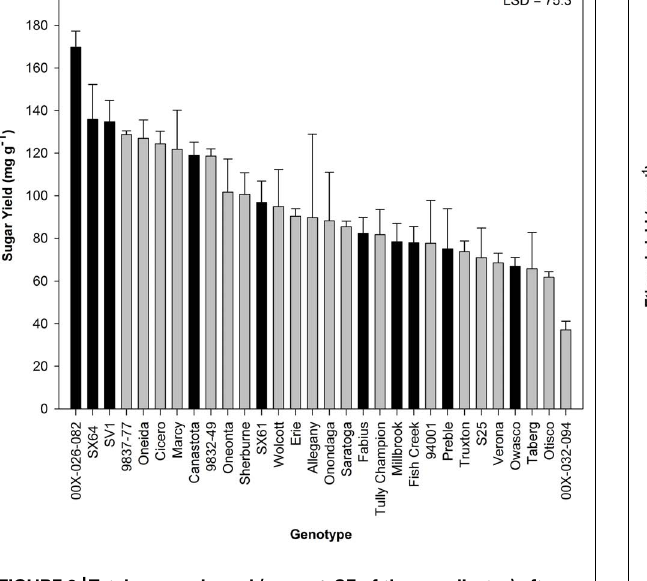
FIGURE 3 |Total sugar released (mean ± SE of three replicates) after enzymatic hydrolysis on untreated biomass. Black bars indicate 10 genotypes selected for pretreatment. Least significant difference (LSD) fromTukey’s studentized range test is indicated.